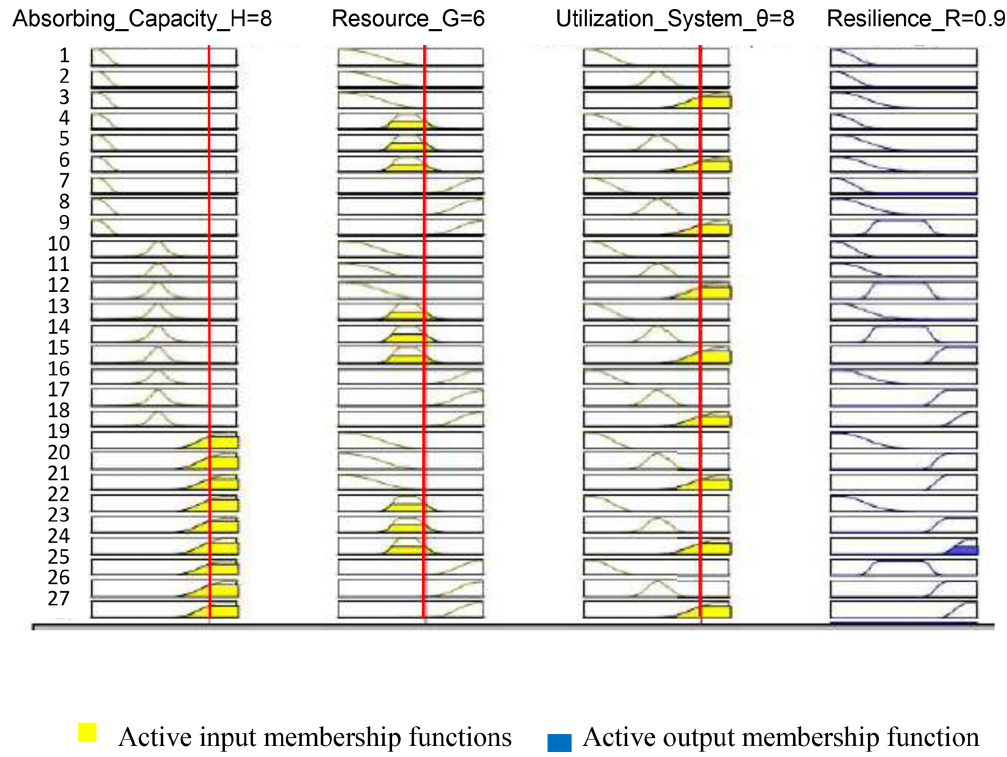
Figure 10. Rule setting and output for Greenville active input membership functions and the active output membership